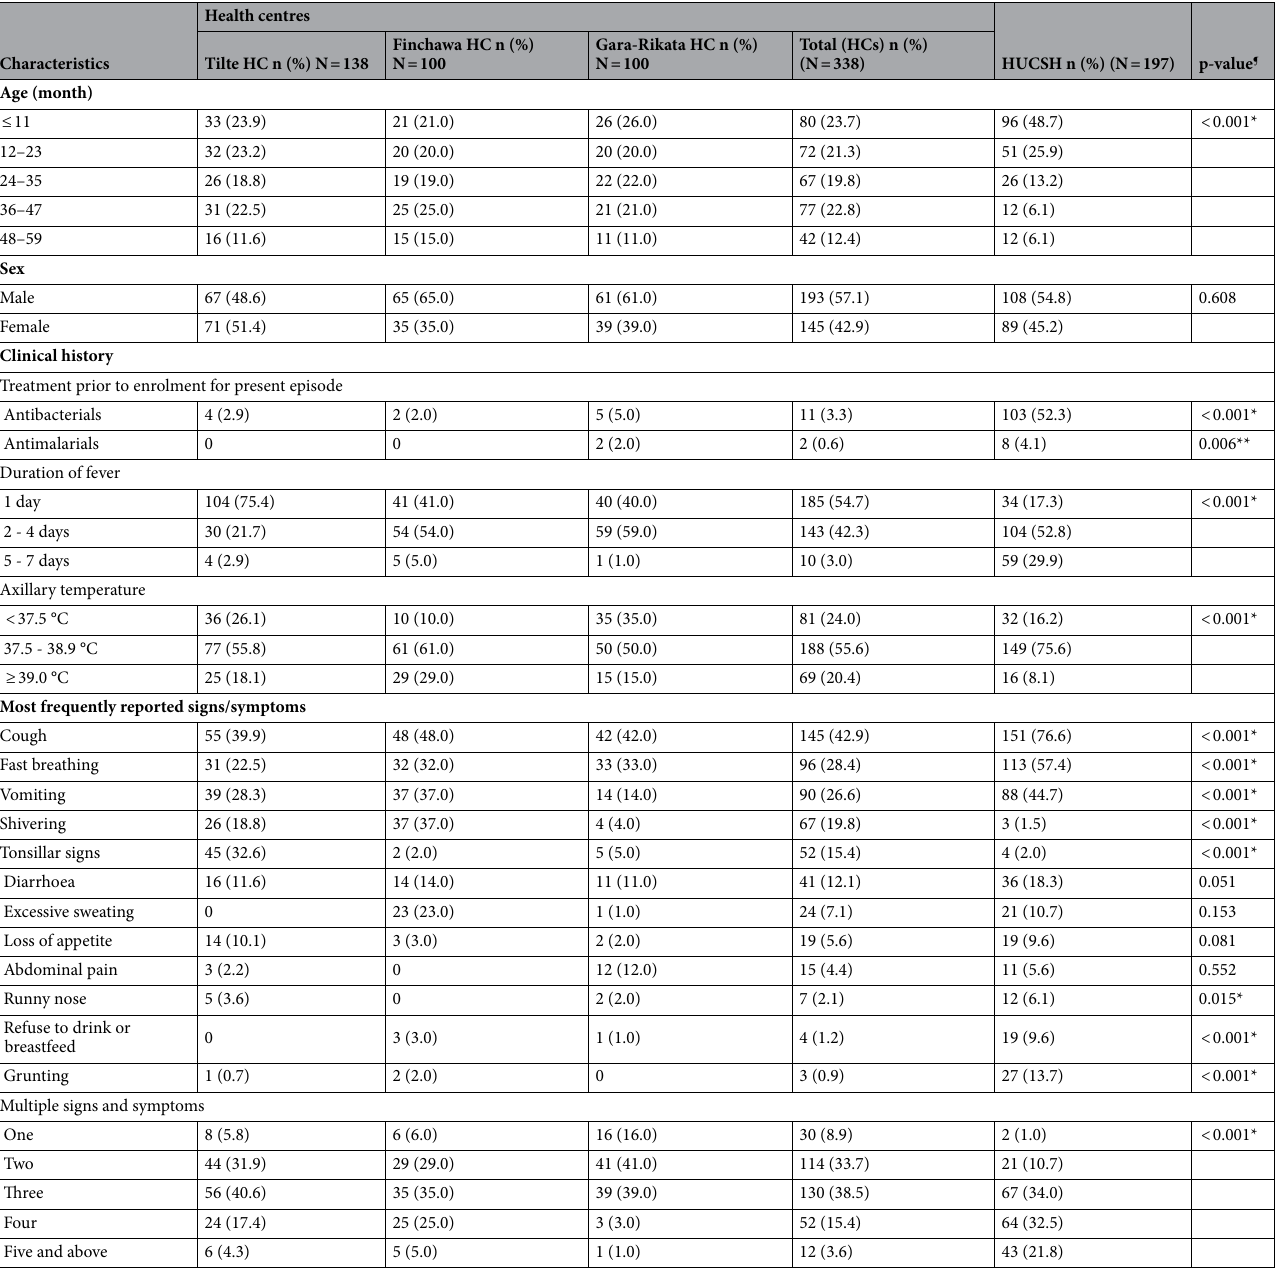
Table 2. Demographic and clinical characteristics of febrile children by study health facilities in Hawassa City, 2019. HC health centre, HUCSH Hawassa University Comprehensive Specialized Hospital. ¶ Comparison of proportions between all health centres and HUCSH. *Significant difference (p-value < 0.05 from chi-square test). **Significant difference (p-value < 0.05 from Fisher’s exact